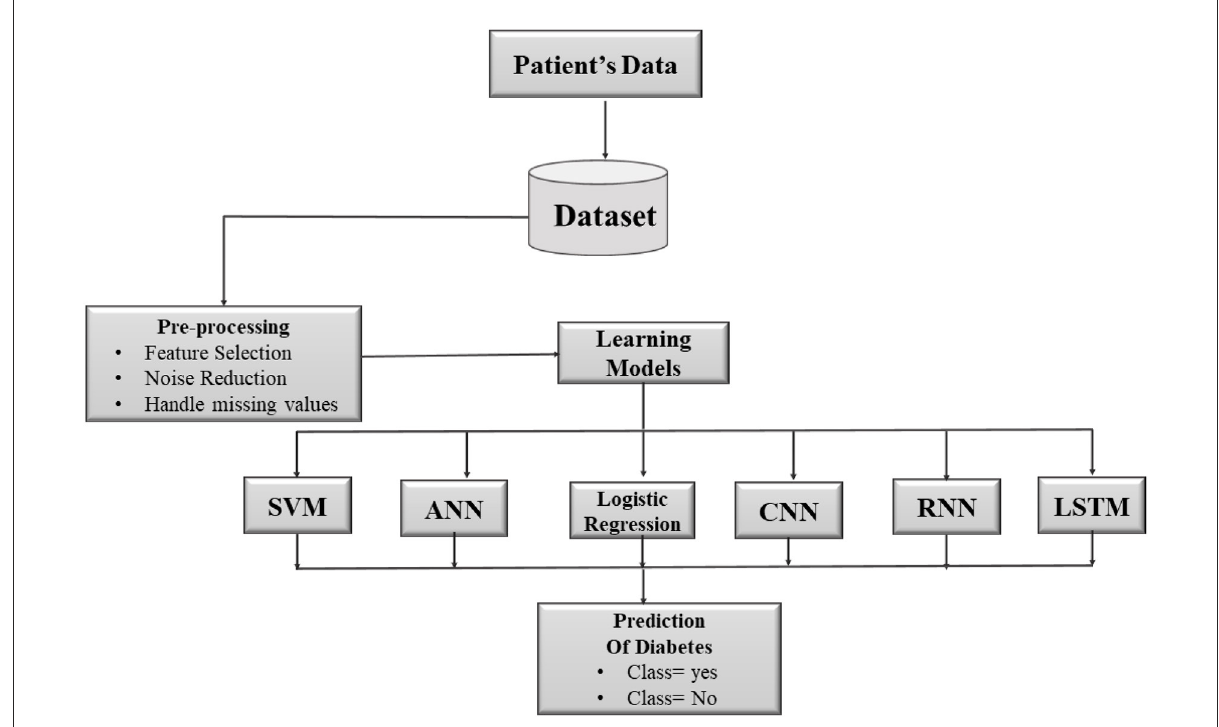
FIGURE1 Architecture of smart patient’s health monitoring